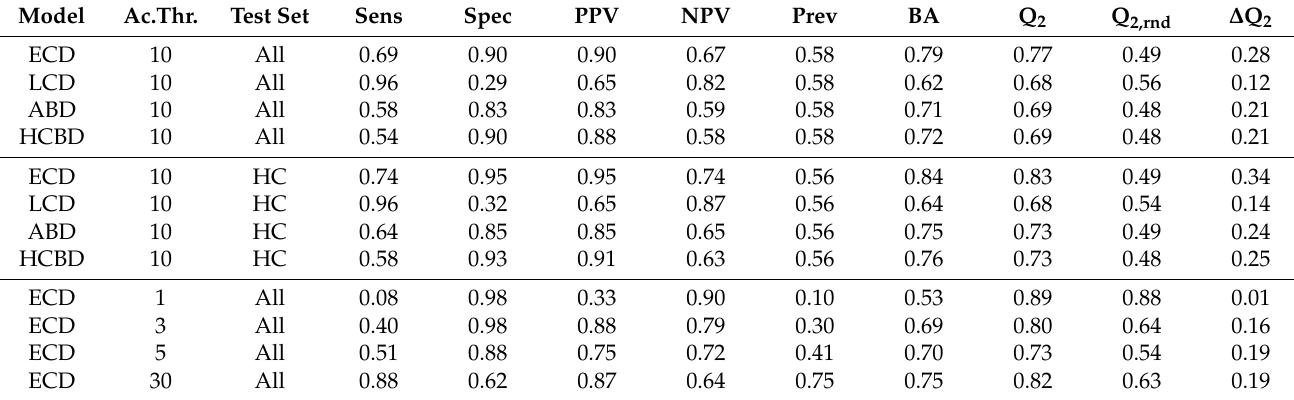
Table 2. Model performance statistics.